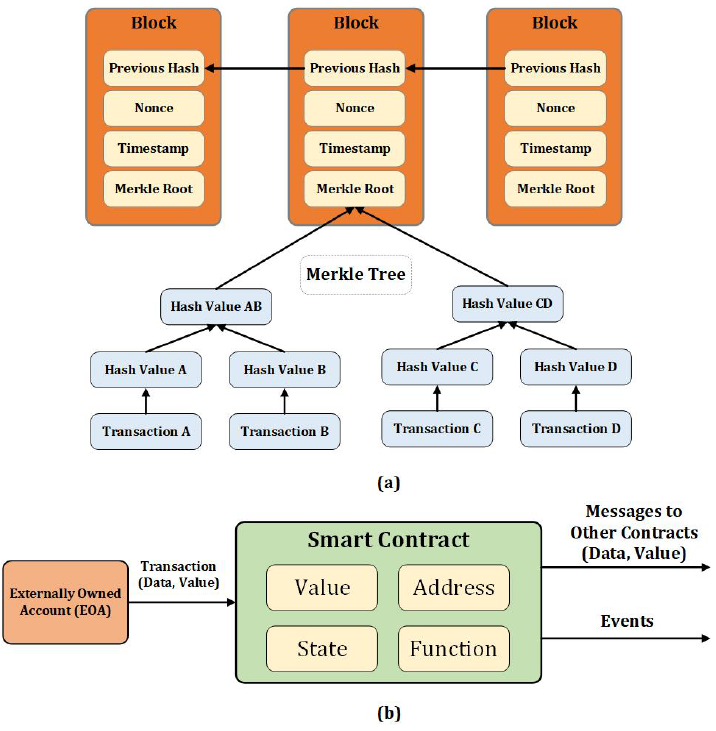
Figure 2. ( a ) Simplified blockchain structure. ( b ) Smart